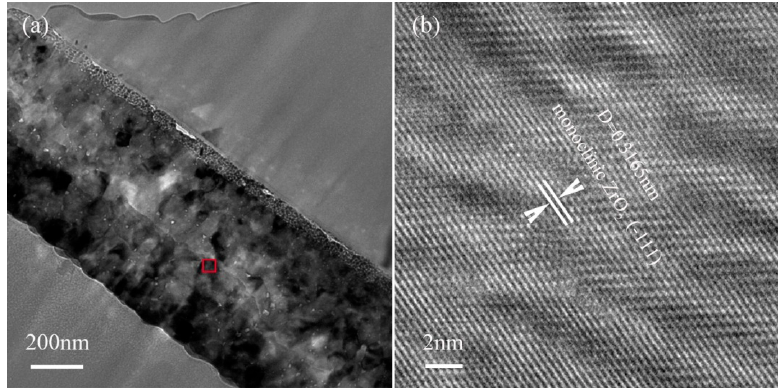
Figure 6. Bright field TEM images of ( a ) annealed ZrO 2 film and ( b ) HRTEM image of the area marked with a red rectangle in ( a ).